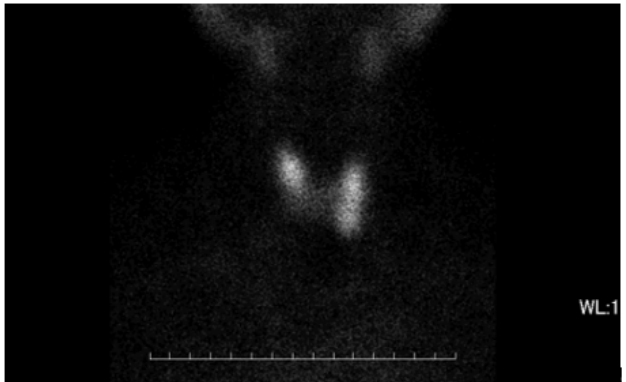
Figure 2. The image of thyroid gland in 99mTc scan. No remarkable accumulation of 99mTc was